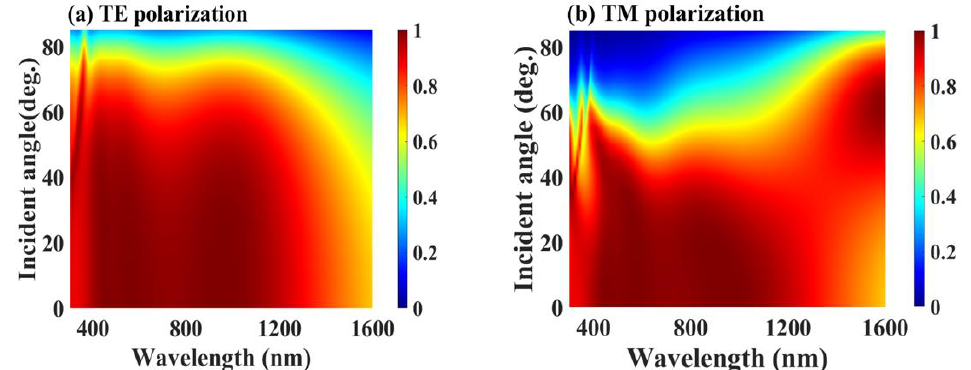
Figure 5. Absorption spectra as a function of various incident angles for ( a ) TE-polarization light and ( b ) TM-polarization ( b ) TM-polarization light.